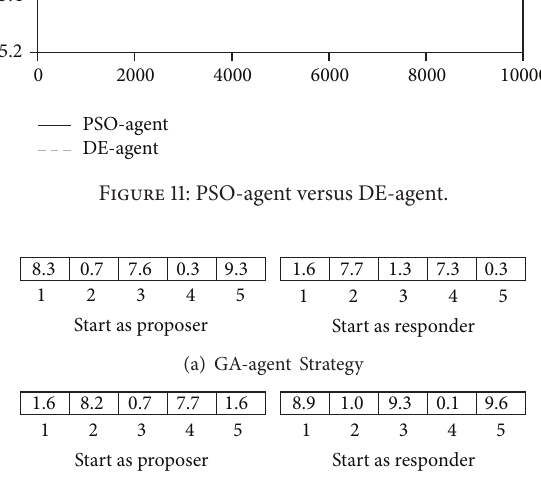
to coevolution in bargaining game. We expect the analysis on the characteristics of artificial agents to help the researchers who study the game theory using artificial